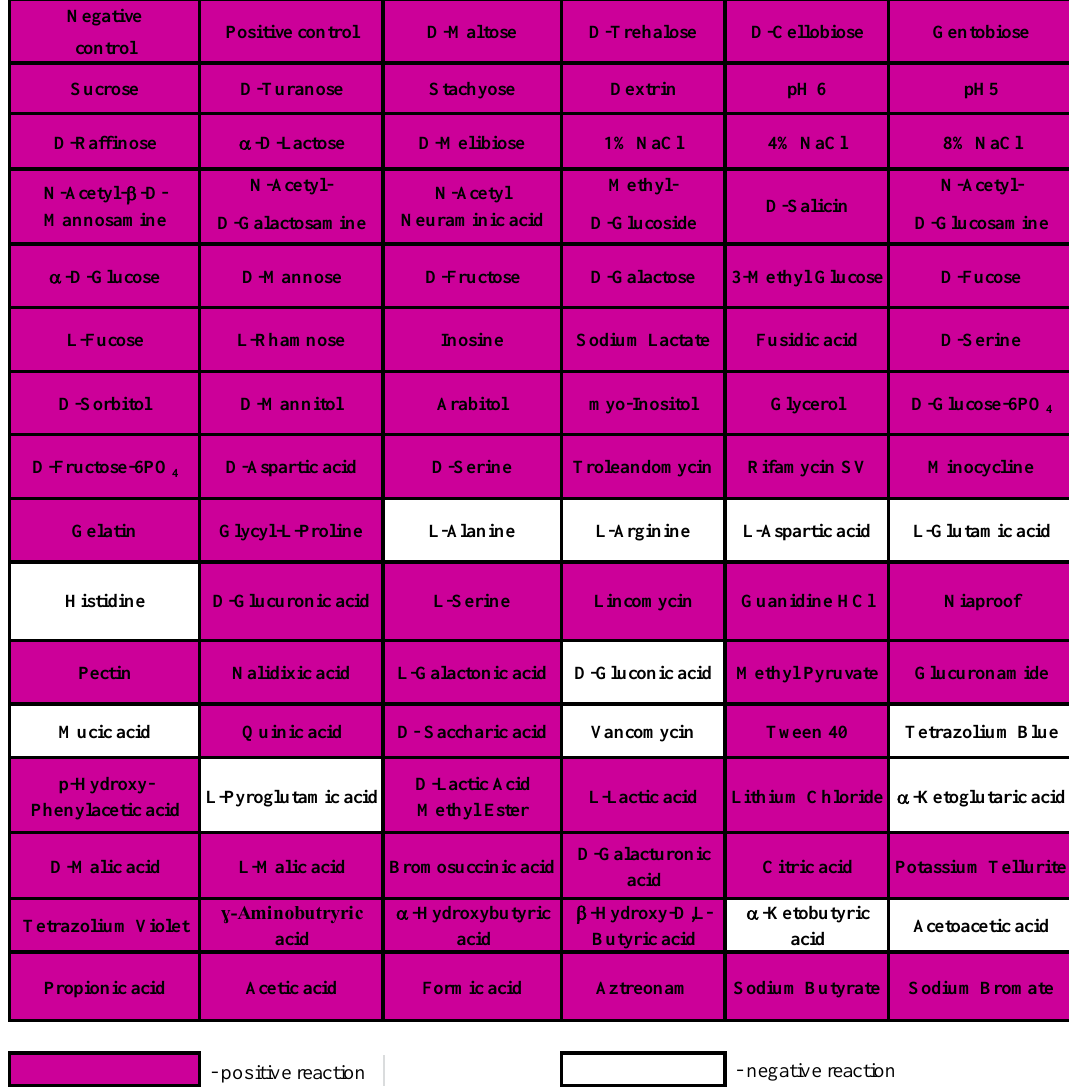
Figure 1. The results of a metabolic activity test analyzing the chemical sensitivity of an environmental Carnobacterium maltaromaticum probiotic isolate and its ability to utilize different carbon sources (GEN III MicroPlate™). Purple color—metabolic activity of the C. maltaromaticum isolate, white color—no metabolic activity of the C. maltaromaticum isolate.